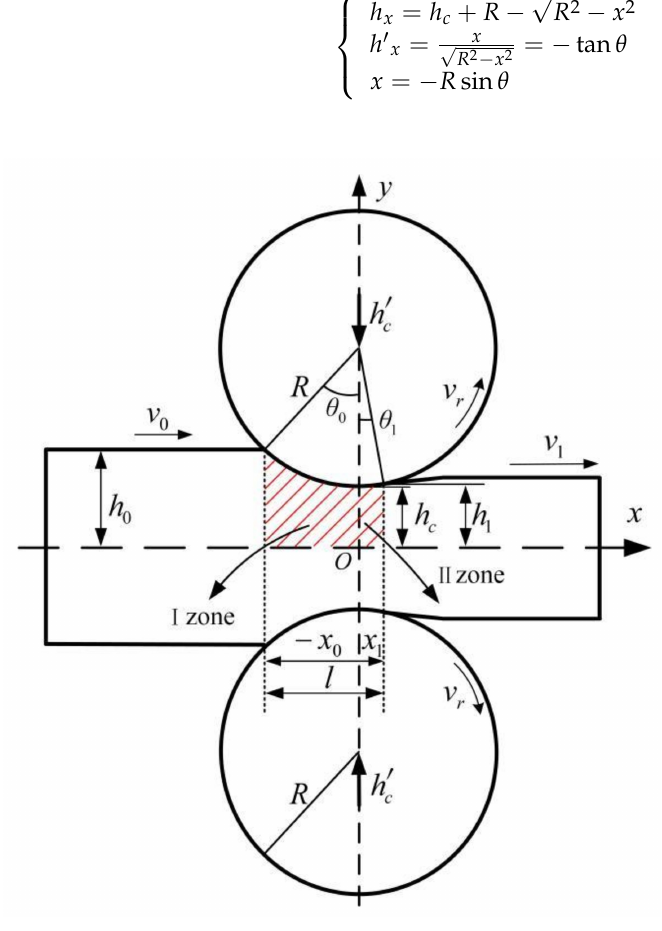
Figure 1. Roll bite geometry during dynamic